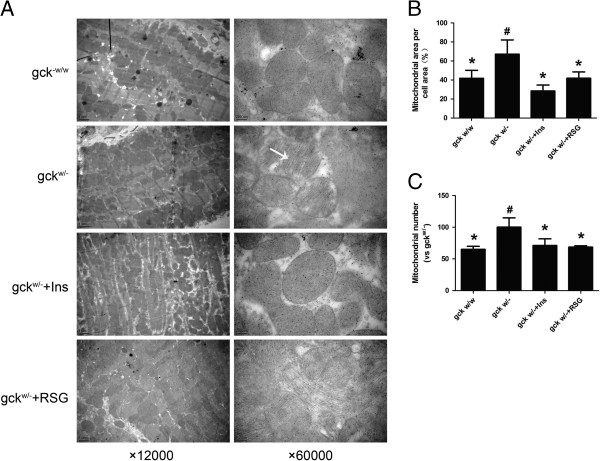
Changes in mitochondrial ultrastructure in the hearts of 60-week old liver-specific gck knockout mice. Representative electron micrographs (×12,000 or × 60,000) (A), stereological quantification of mitochondrial volume density (B), and mitochondrial number (C) of wild-type (gckw/w) and gck knockout (gckw/–) mice as well as knockout mice treated with insulin or rosiglitazone for 4 weeks are shown. Cristae density (white arrow) was decreased in the gckw/–mice. Asterisk (*) refers to statistical significance (P < 0.05) in comparisons with gckw/– mice, while # refers to comparisons with gckw/w mice.